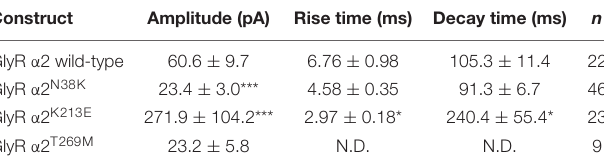
TABLE 2 | Properties of wild-type and mutant GlyRs measured using whole-cell patch-clamp electrophysiology in HEK293 cells. Construct TABLE 3 | Properties of IPSCs mediated wild-type and mutant GlyRs in artificial